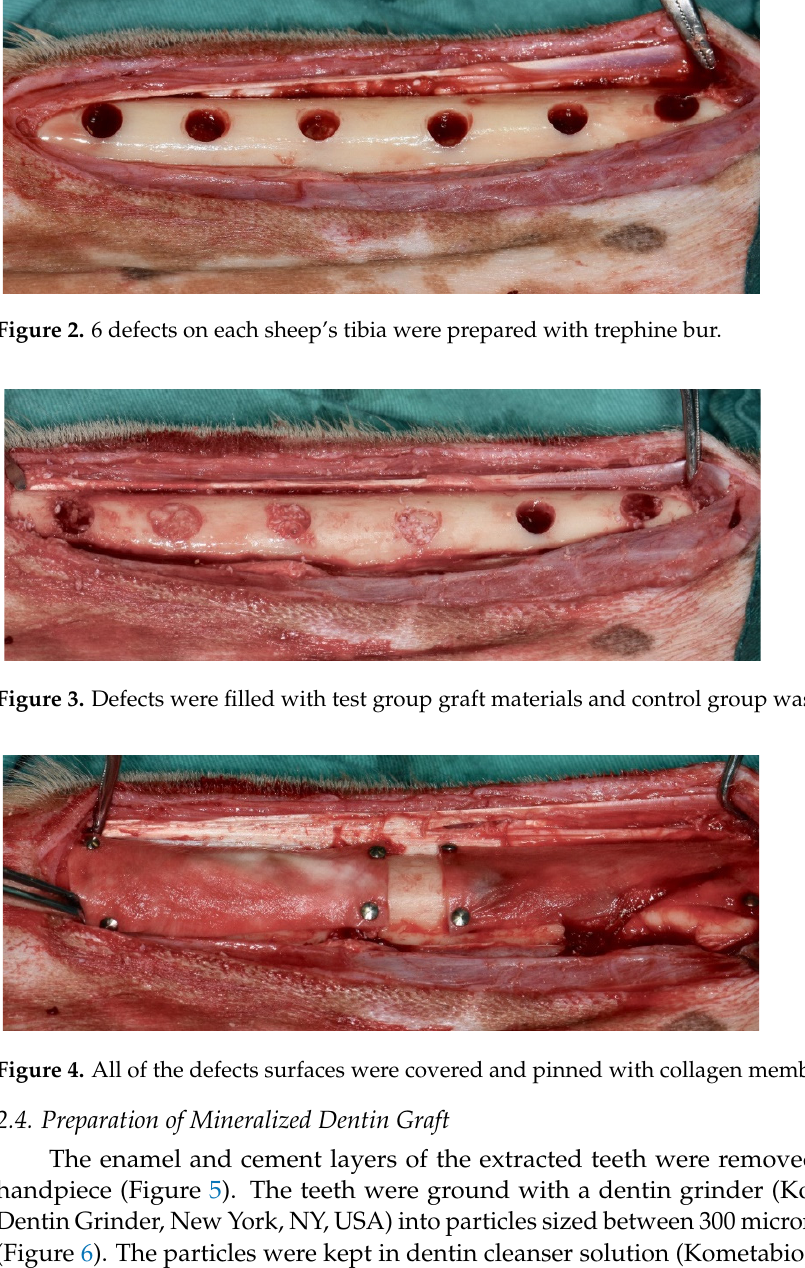
Figure 1. Right and left third incisor teeth on the sheep’s mandibula were extracted.